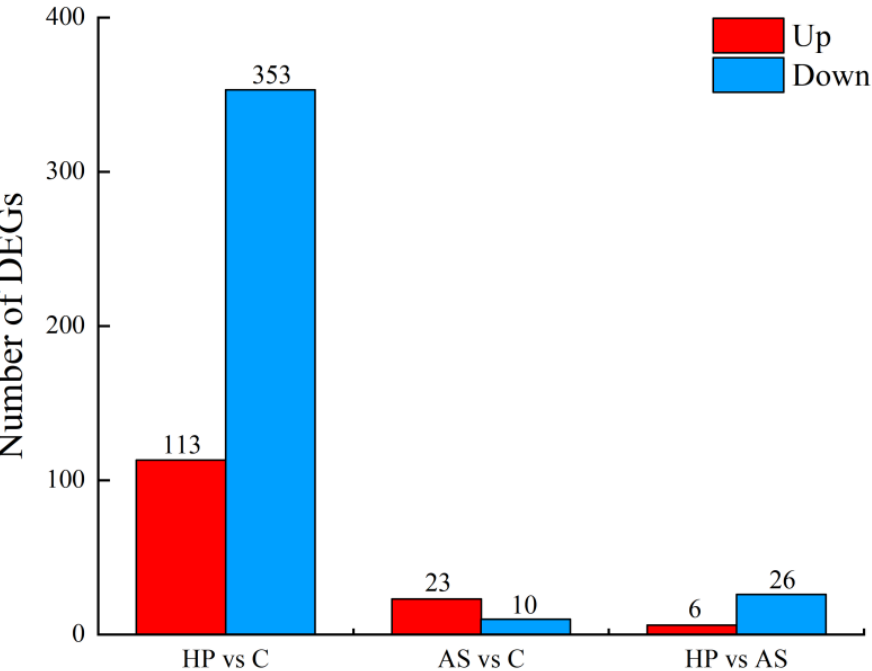
Figure 2. The number of differentially expressed genes in the three comparison groups. Red is the up-regulated genes, blue is the down-regulated genes. The letter C is control, AS is synthetic astaxanthin, HP is natural astaxanthin. Table 3. Differentially expressed genes associated with body color.